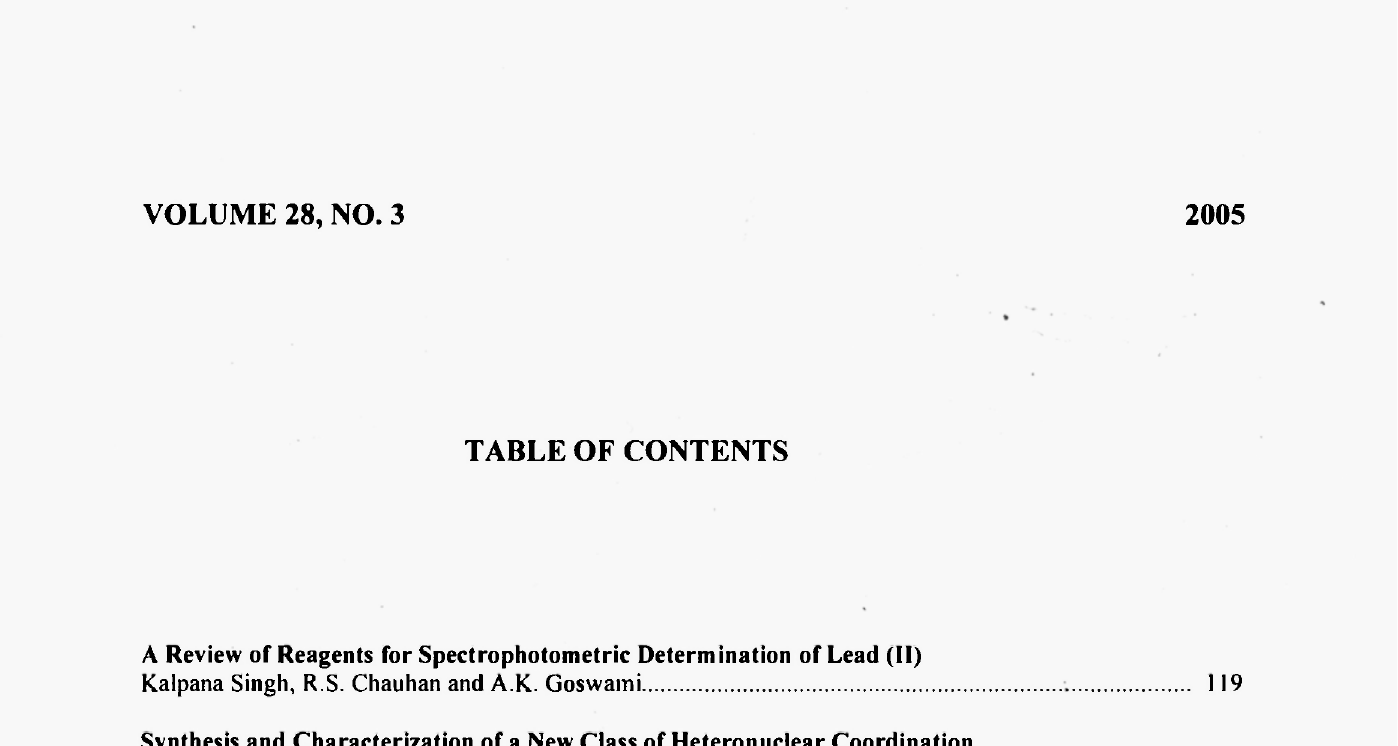
Α Review of Reagents for Spectrophotometric Determination of Lead (II) Kalpana Singh, R.S. Chauhan and A.K. Goswami Synthesis and Characterization of a New Class of Heteronuclear Coordination Compounds of Aluminium Derived from Bifunctional Tridentate Schiff Base Ligands Seema Bansal, Yash P. Singh and Anirudh Singh Synthesis and Spectroscopic Properties of Some New Types of Heterobimetallic Derivatives Involving Organotin(IV) and Ge(Oet) 3